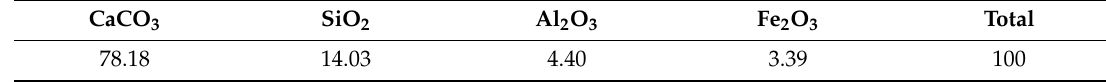
Table 3. Raw material composition of cement clinker without alkali